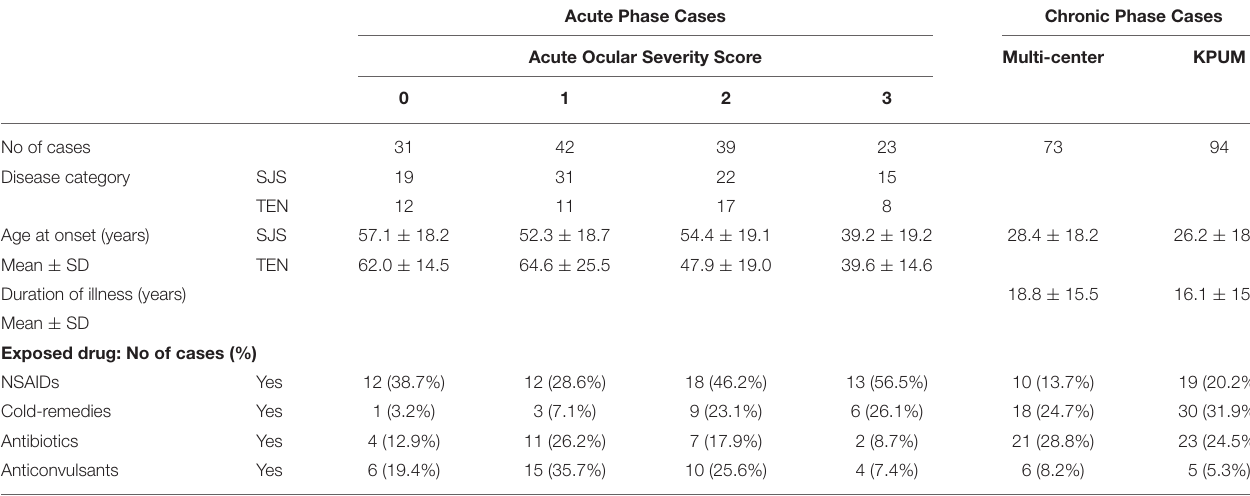
defect or pseudomembrane formation, and Score 3 (very severe) = both ocular-surface epithelial defect and pseudomembrane formation (4). Chronic phase cases were summarized from our multi-center study in Japan (7) and our retrospective analysis for cases seen at Kyoto Prefectural University of Medicine (8).